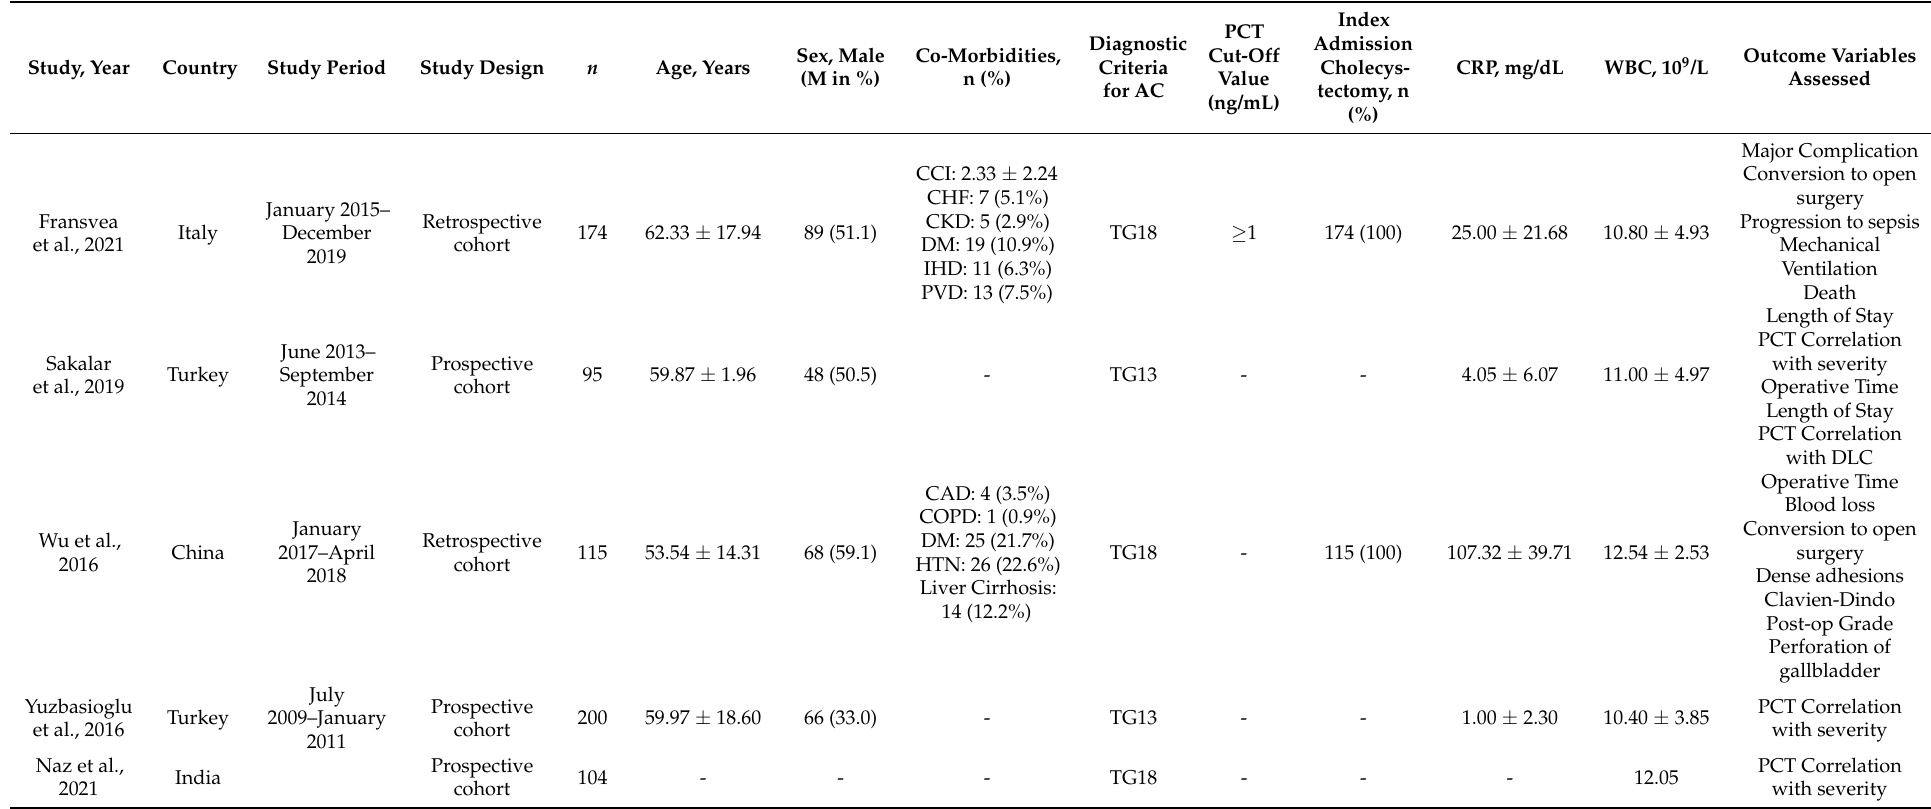
Table 1. Characteristics of included studies (n =